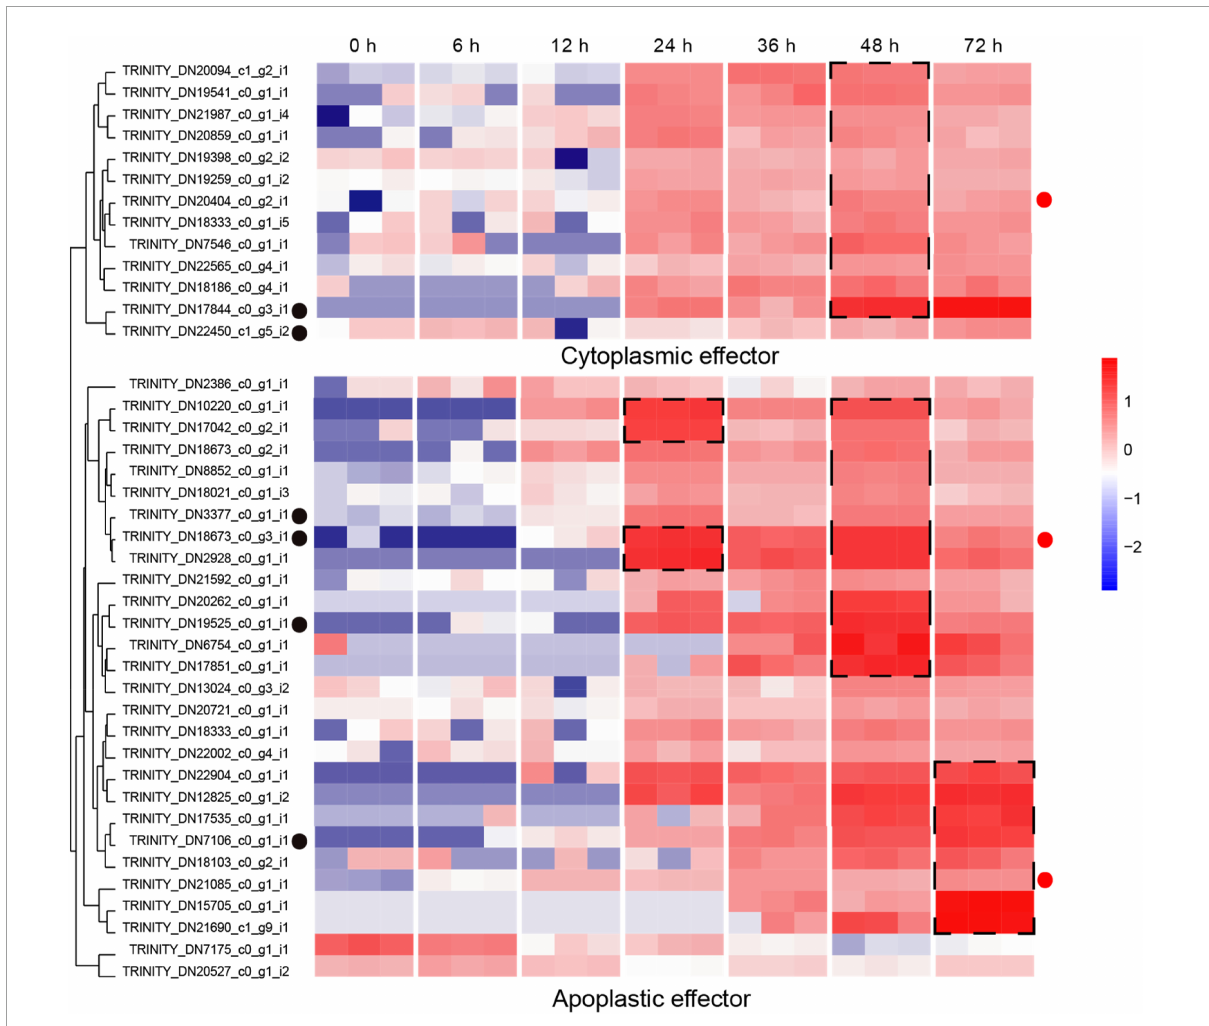
FIGURE6 Expression patterns of candidate apoplastic and cytoplasmic effectors The heatmap represents apoplastic and cytoplasmic effectors genes expression (RPKM in log10-scale). The genes retrieved from Pfam, Blast and reads counts ( > 50). The up-regulated clusters were showed in dot black boxes. The red circles next to the heatmap were candidate genes tested by